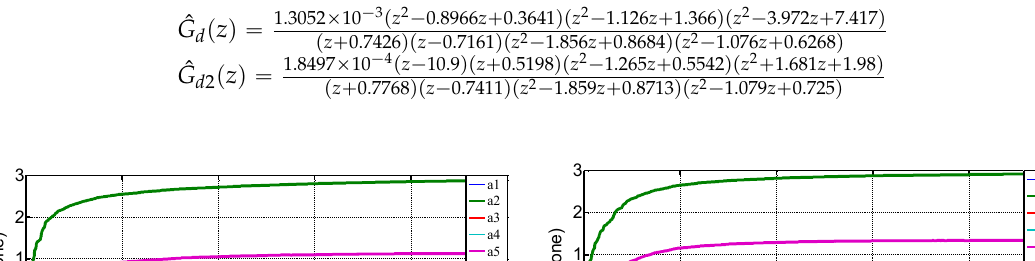
Figure 21. Frequency characteristics with proposed synchronization controller. ( a ) Magnitude